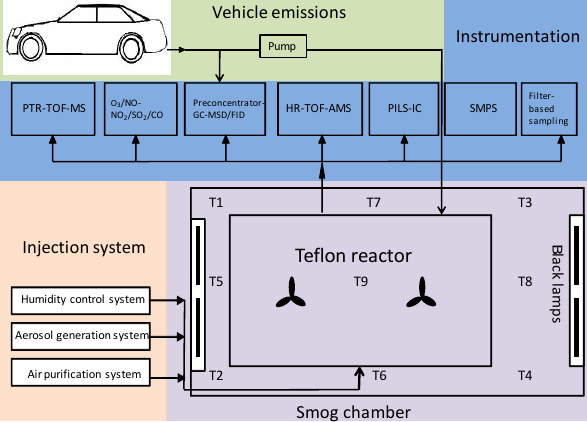
Figure 1. Schematic of the GIG-CAS smog chamber facility and vehicle exhaust injection